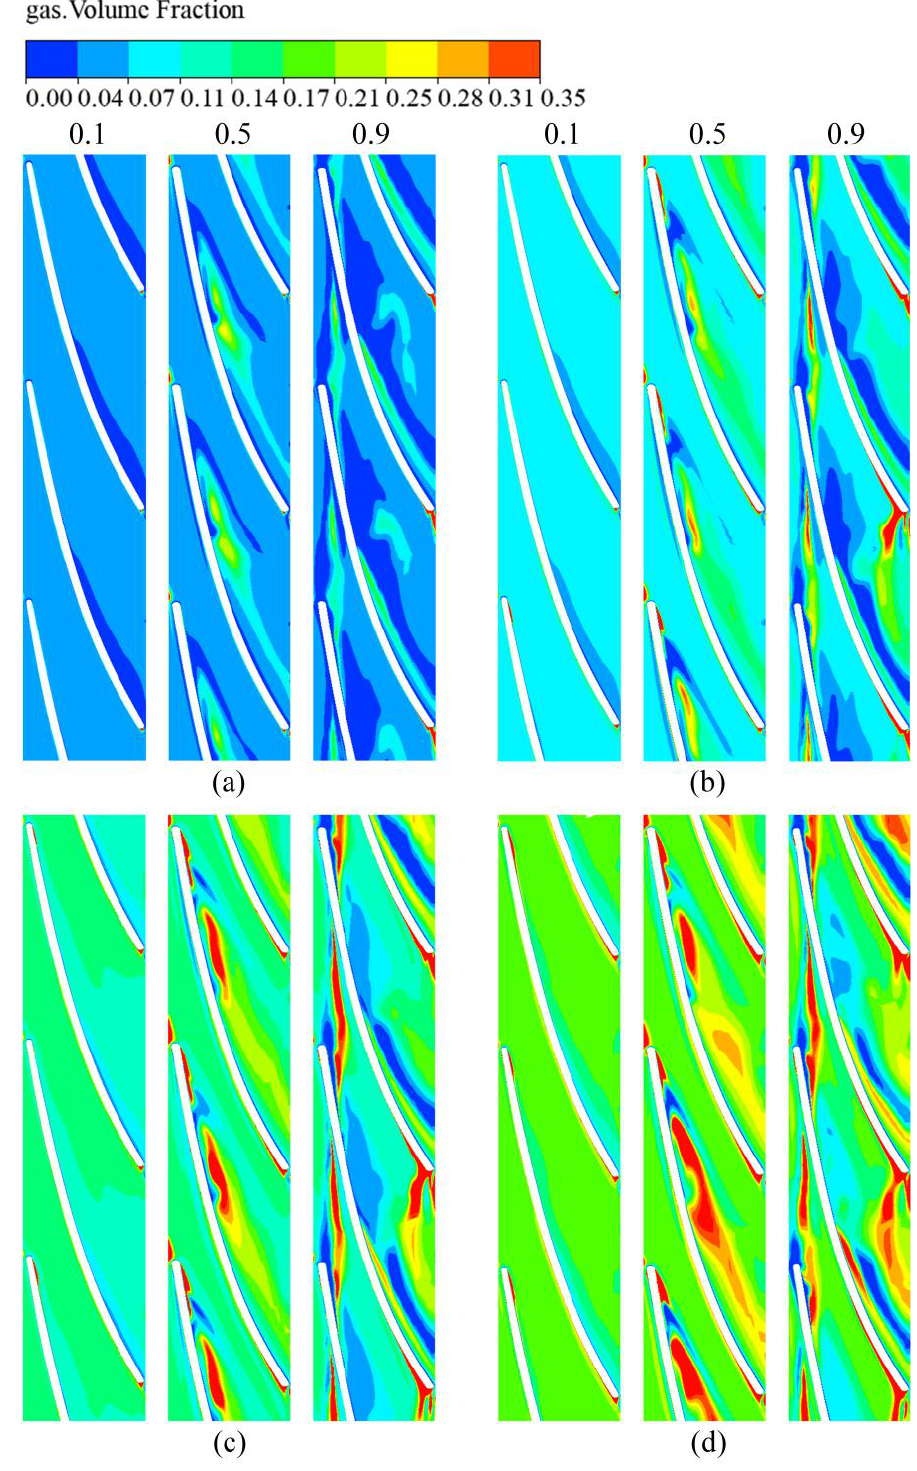
Figure 13. Gas volume fraction in the passage. ( a ) IGVF = 5%; ( b ) IGVF = 10%; ( c ) IGVF = 15%; and ( d ) IGVF = 20%.